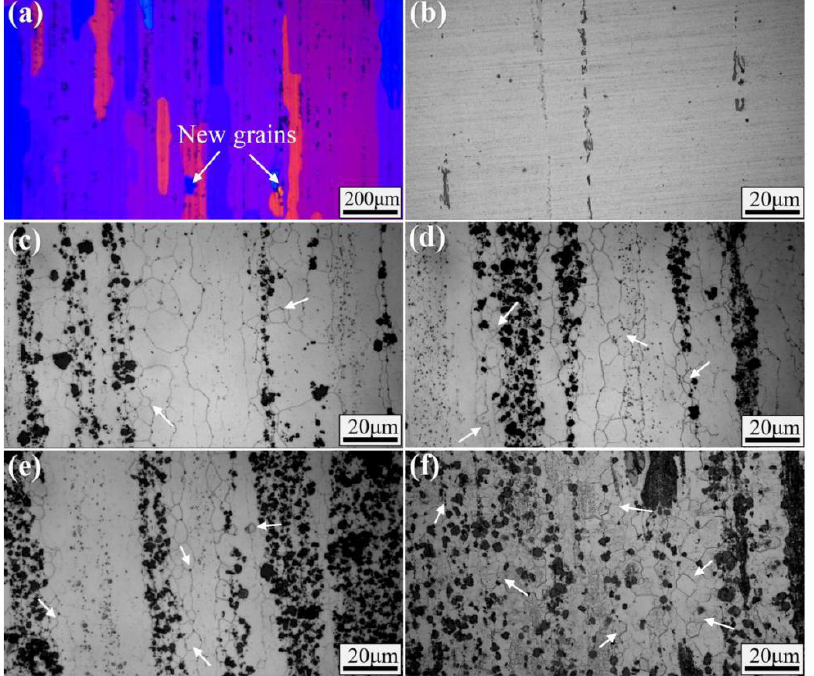
Figure 8. Microstructures along the extrusion direction. ( a ) Al-Cu-Mg-Si alloy; ( b ) 0.5 wt% CNTs/Al- Cu-Mg-Si composites; ( c ) 1.0 wt % CNTs/Al-Cu-Mg-Si composites; ( d ) 1.5 wt % CNTs/Al-Cu-Mg-Si composites; ( e ) 2.0 wt % CNTs/Al-Cu-Mg-Si composites; ( f ) 3.0 wt % CNTs/Al-Cu-Mg-Si composites.